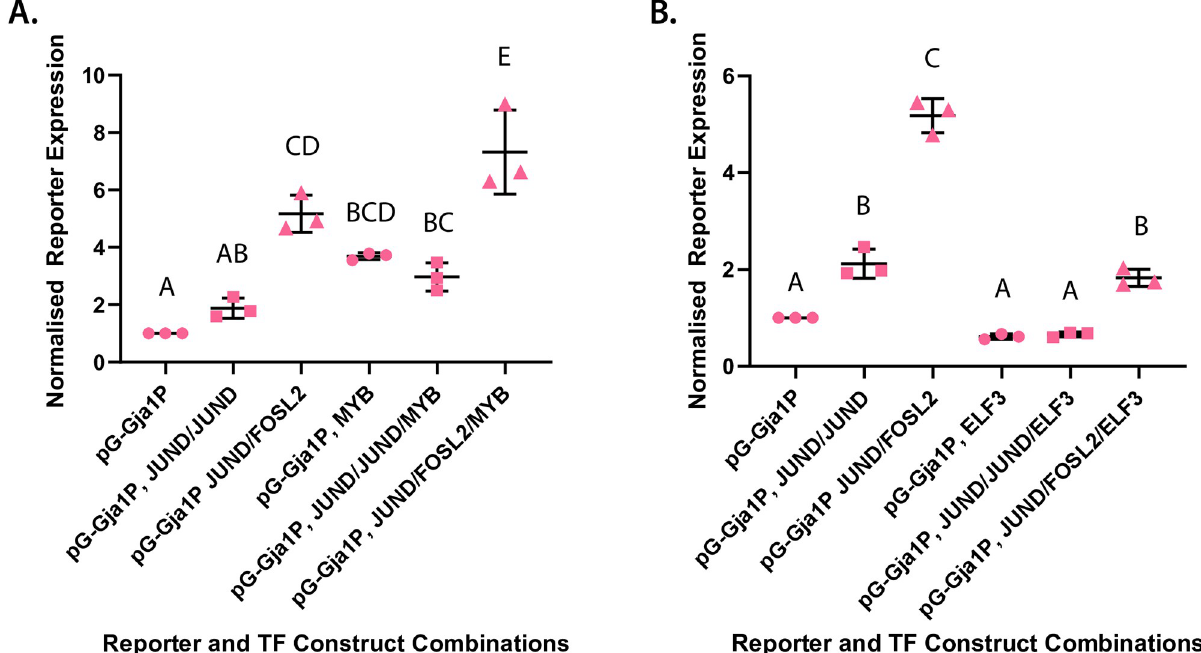
Fig 3. MYB up-regulates while ELF3 down-regulates basal and AP-1 dimer-induced Gja1 promoter activity. Reporter expression levels from construct with luciferase reporter gene under control of murine Gja1 promoter (Gja1P) relative to expression output of Renilla reporter plasmid. Cell treatment with (A) MYB alone, MYB and JUND:JUND homodimers, and MYB and JUND:FOSL2 heterodimers compared against control set in the absence of MYB; and (B) ELF3 alone, ELF3 and JUND:JUND homodimers, and ELF3 and JUND:FOSL2 heterodimers compared against control set in the absence of ELF3. Average expression level values ( ± S.D.) for each construct normalized to expression output of promoter construct subject to no transcription factor treatment. Groups determined by one-way ANOVA to be significantly different (p < 0.05) from one another are labeled with different letters; to indicate p > 0.05, groups are labeled with the same